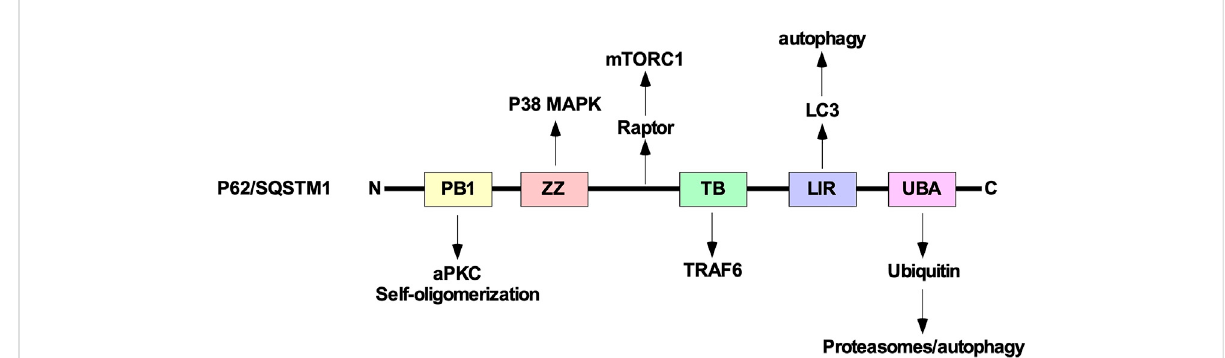
FIGURE 12 The structure of p62/SQSTM1. From the amino (N)-terminal to carboxyl (C)-terminal, p62/SQSTM1 is comprised of the phox bem1 (PB1), ZZ- type zinc fi nger (ZZ), tumour necrosis factor receptor-associated factor (TRAF) binding (TB), microtubule-associated protein light chain 3 (LC3)- interacting region (LIR), and ubiquitin-associated (UBA) domains. The PB1 domain allows protein 62/sequestosome 1 (p62/SQSTM1) to interact with atypical protein kinase C (aPKC) and self-oligomerize. The ZZ and TB domain have been shown to interact with downstream transforming growth factor- β (TGF β ) signalling molecules, such as p38 mitogen-activated protein kinase (MAPK) and TRAF6, respectively. Between the ZZ and TB domains, p62/SQSTM1 associates with Raptor, which is a component of mechanistic target of rapamycin complex 1 (mTORC1). The LIR binds to LC3 and is necessary to facilitate selective autophagy. The UBA domain recognizes ubiquitin prior to delivering ubiquitin-conjugated proteins to proteasomes or lysosomes.